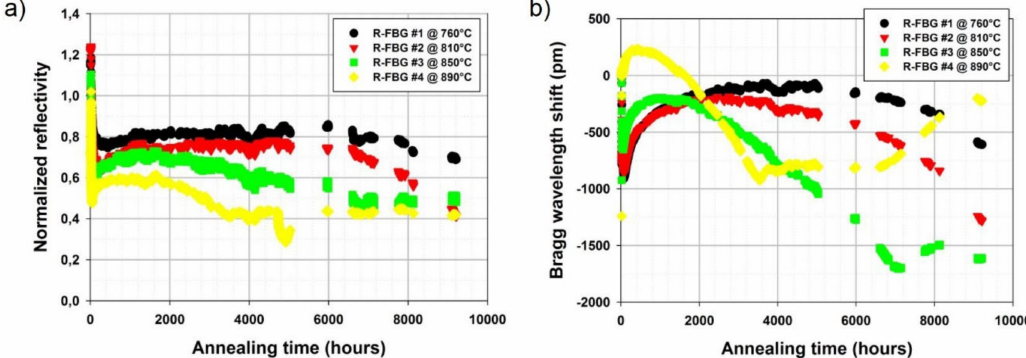
Figure 3. Long-term annealing data of RFBGs. ( a ) normalized reflectivity and ( b ) Bragg wavelength drift (reproduced from [49]).